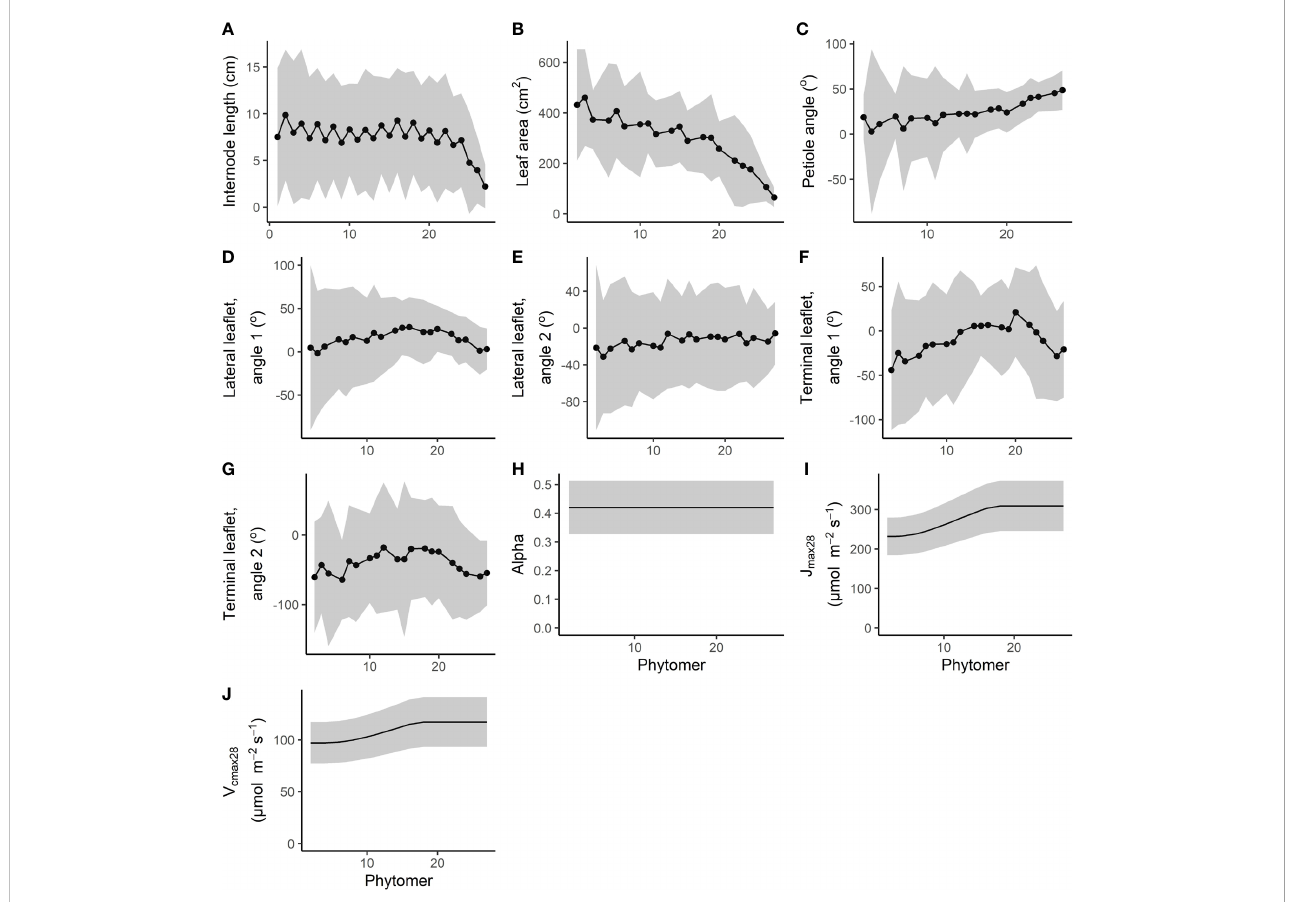
FIGURE 2 Measured interplant variation of (A – G) architectural traits combined from the two glasshouse experiments (for details on how the architectural parameters were measured, see Figure 1), as well as (H – J) interplant variation in photosynthesis traits. Alpha, J max28 , and V cmax28 mean values with variation were taken from Qian et al. (2012) who performed measurements on two heights. Mean values for J max28 and V cmax28 were assumed equal from the fi rst to the ninth top from the leaf and then decreased exponentially as a result of lower light levels from the 10th leaf from the top to the lowest leaf of the plant. Variation in photosynthesis parameters was kept relational to the mean. Data are represented as the mean ±2 times the standard deviation. Every fourth phytomer bears a truss instead of a leaf and is therefore presented as missing data, with the exception of internode